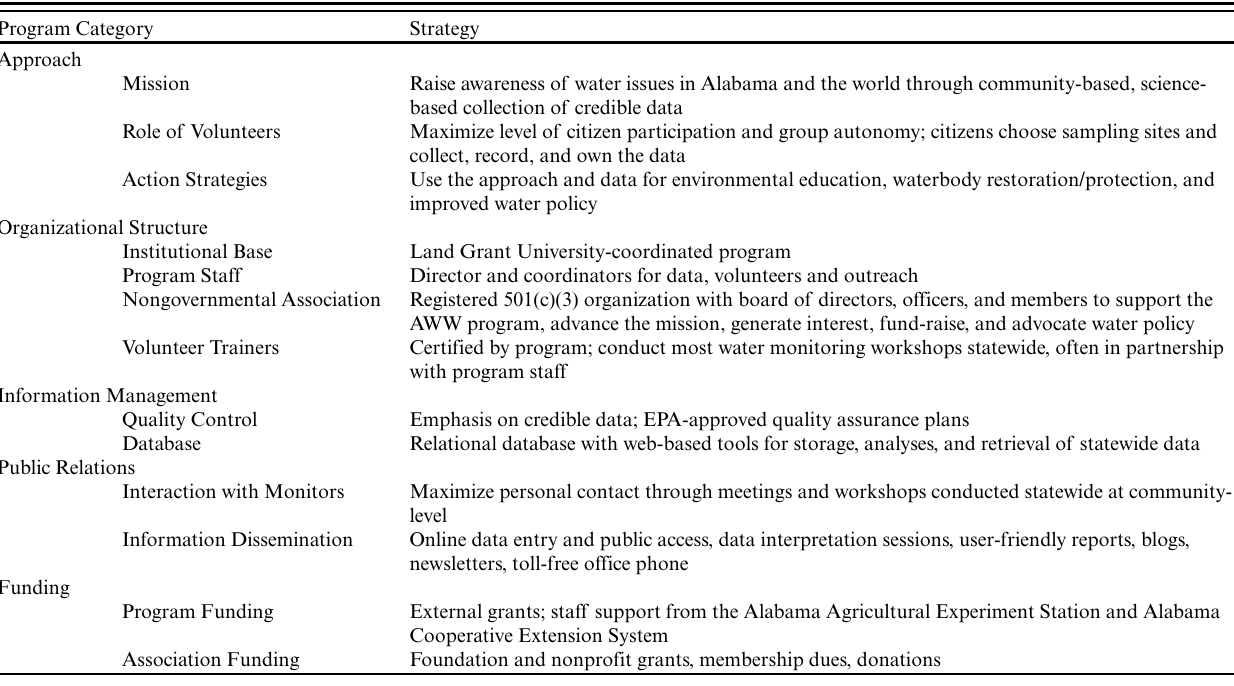
Table 1 . Characteristics of Alabama Water Watch (AWW) according to five program categories and strategies,